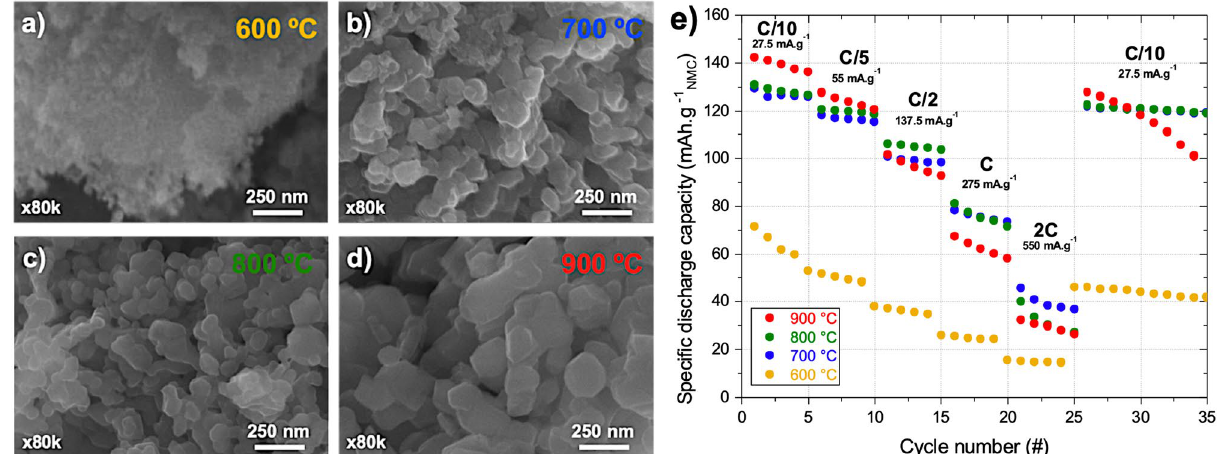
Figure 4. ( a-d ) Representative SEM micrographs of the NMC 111 materials synthesized at four different maximum temperatures. ( e ) Rate capability tests results for the four NMC 111